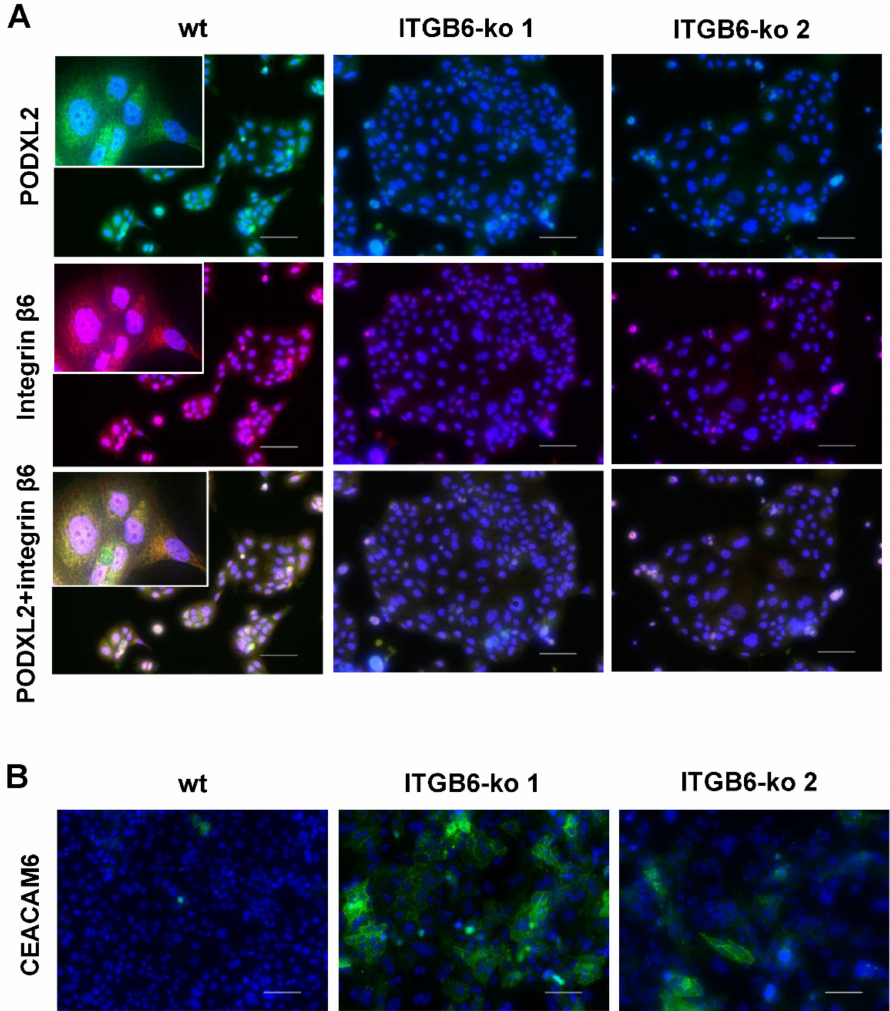
Figure 5. Immunofluorescence staining of podocalyxin-like protein 2 (PODXL2), integrin β 6, and CEA cell adhesion molecule 6 (CEACAM6) in HuCCT1 wild-type (wt) and integrin β 6-knockout ( ITGB6 -ko) cells. ( A ) PODXL2 (green) was strongly expressed in HuCCT1-wt cells and significantly downregulated in ITGB6-ko cells. The expression of integrin β 6 is shown in red. Merged images of PODXL2 and integrin β 6 are yellow (inset), indicating colocalization of PODXL2 and integrin β 6. ( B ) CEACAM6 was localized to the cell membrane and cytoplasm and was increased in ITGB6 -ko cells compared with wild-type cells. (Scale bar, 100 µ